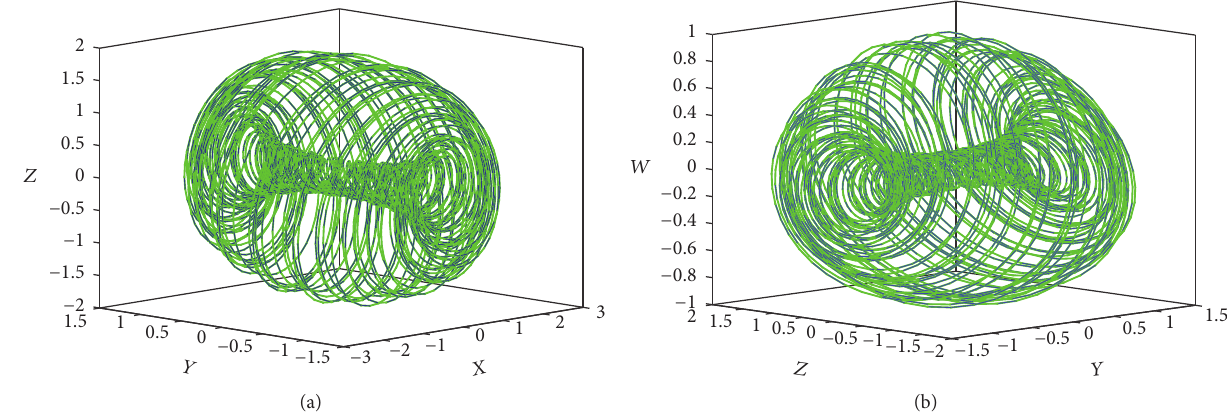
Figure 1: 3D state portrait of the novel memristor no equilibrium system ( 𝑋𝑌𝑍 plane; 𝑌𝑍𝑊